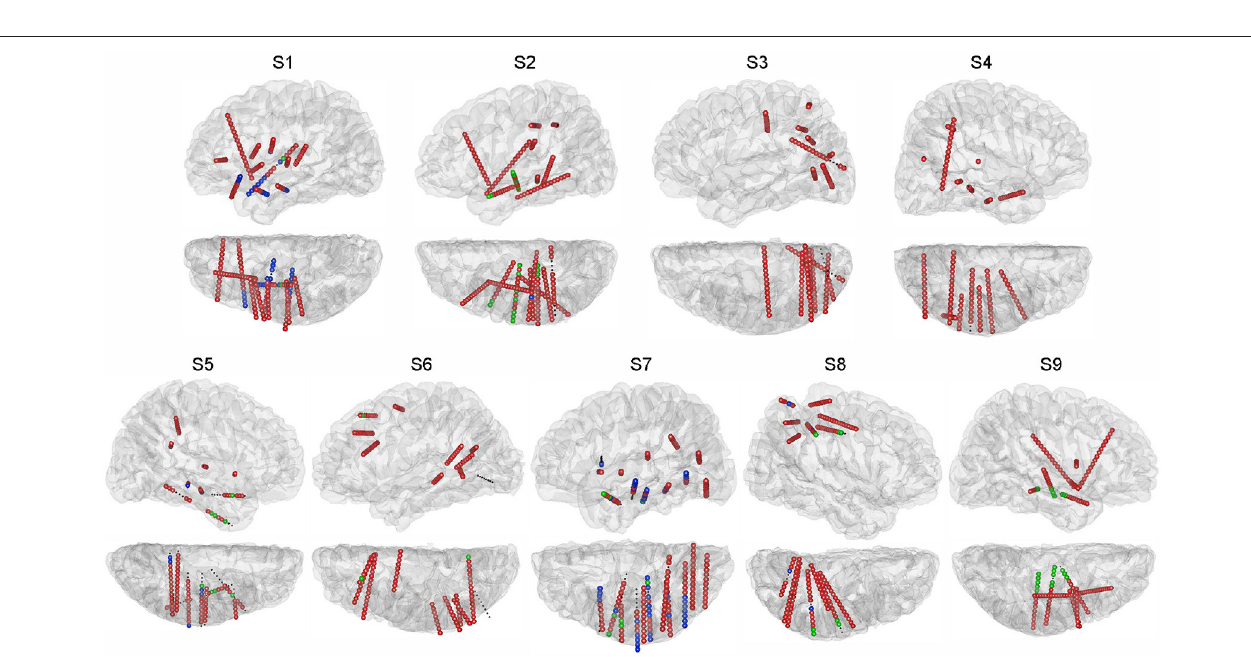
FIGURE 1 | Experimental paradigm. In each session, the subject received his name and the other name aurally or visually. The two names were repeated in a pseudo-random sequence. Subjects performed mental recognition of the name. Four of the subjects heard a short burst in the auditory session and saw a cross in the visual session before the name presentation.